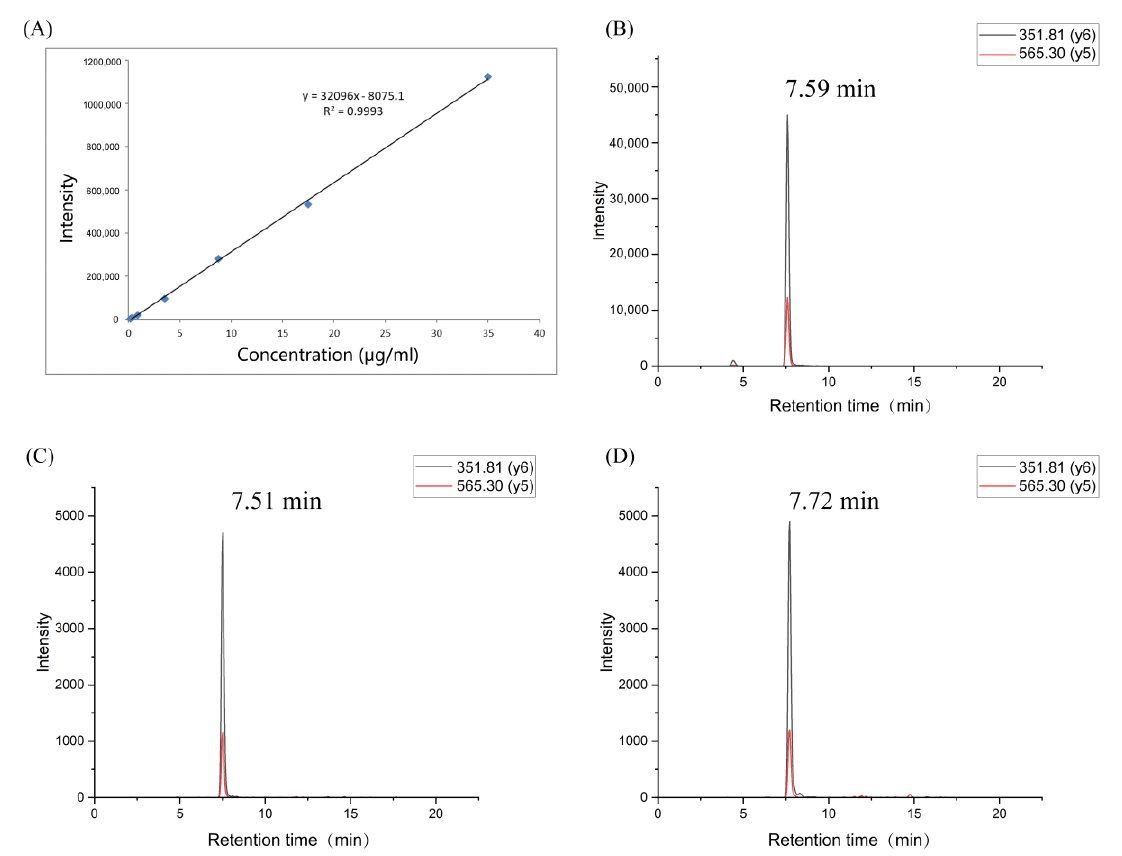
Figure 5. Scatter plot between the standard concentration and peak area of peptide MVHMASKE ( A ). Representative extracted ion chromatogram of synthesized peptide MVHMASKE ( B ) and identified peptide MVHMASKE in samples during storage at 4 °C ( C ) and 25 °C ( D ).